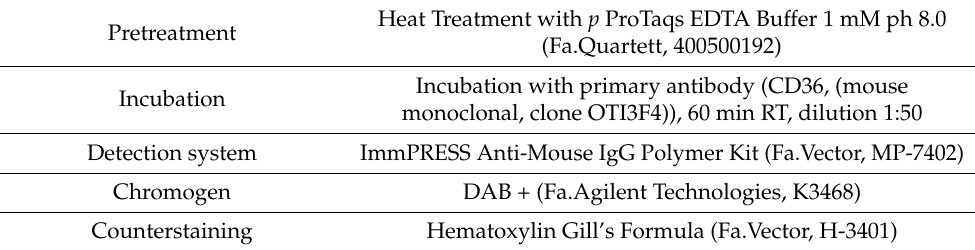
Table 1. Immunohistochemistry